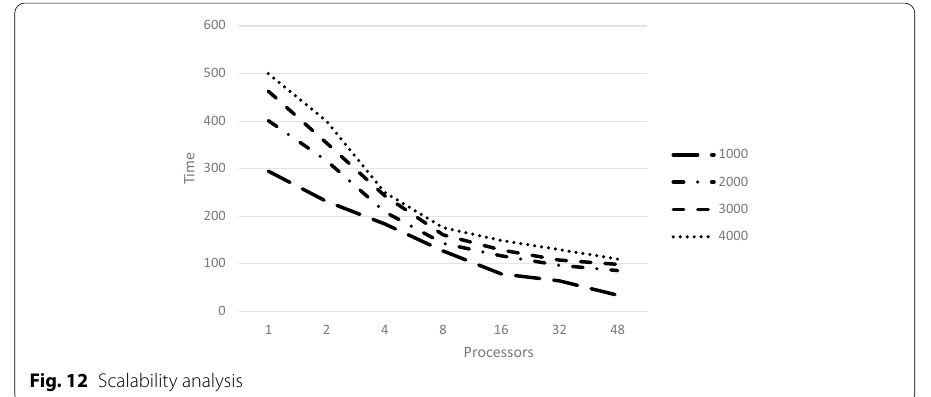
Fig. 12 Scalability analysis